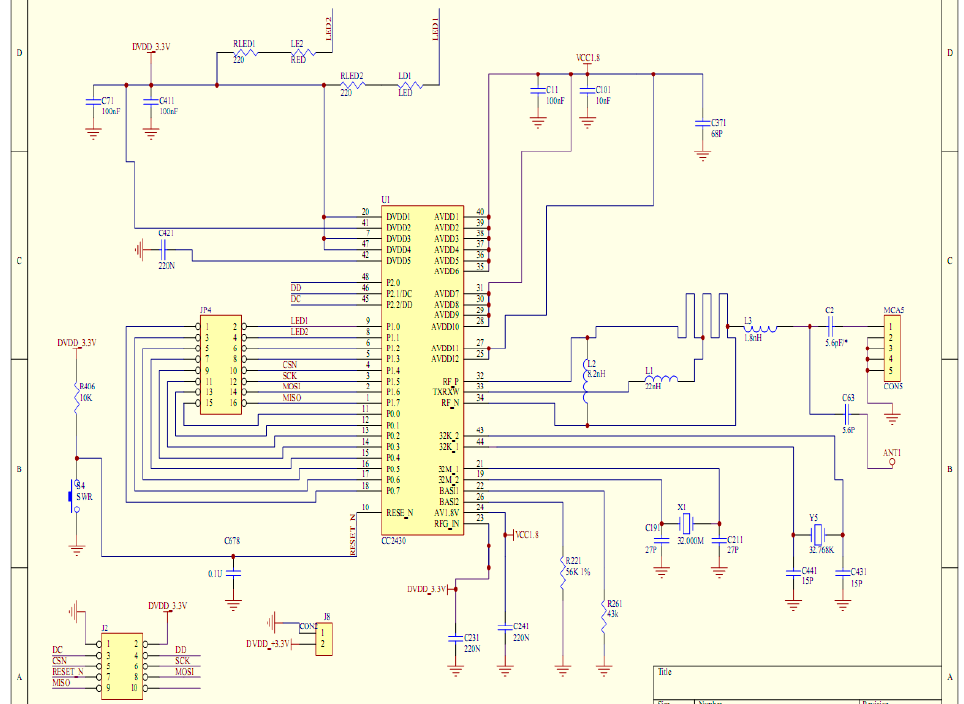
Figure 3. Part of the circuit diagram of the sensor node.